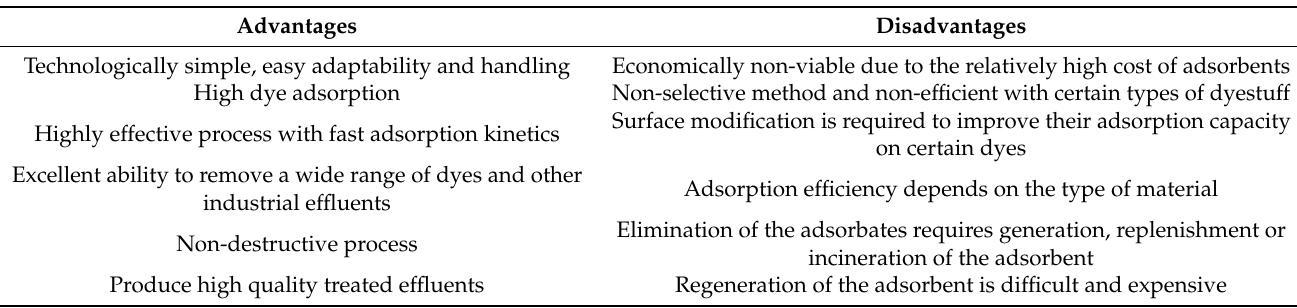
Table 3. Advantages and disadvantages of the adsorption techniques.